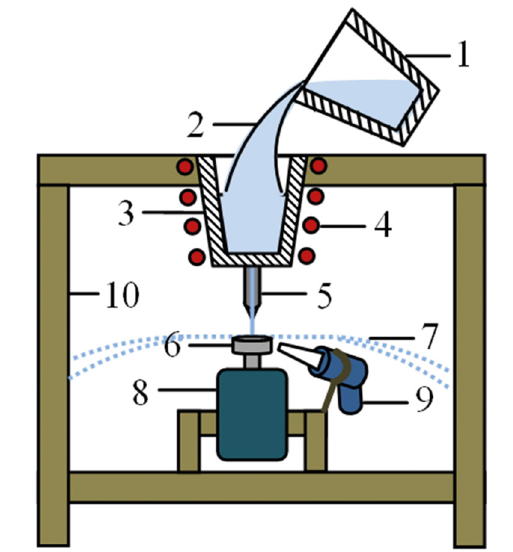
Figure 2 . A schematic of the laboratory device constructed for centrifugal atomisation, in operation.